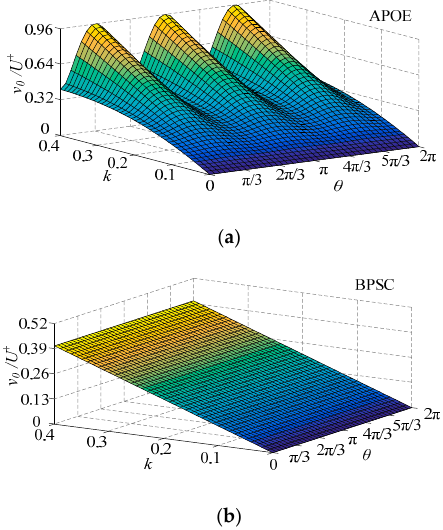
Figure 5. Relationships among the zero-sequence voltage amplitude, unbalanced factor and the phase angle of the negative sequence voltage. ( a ) APOE. ( b ) BPSC